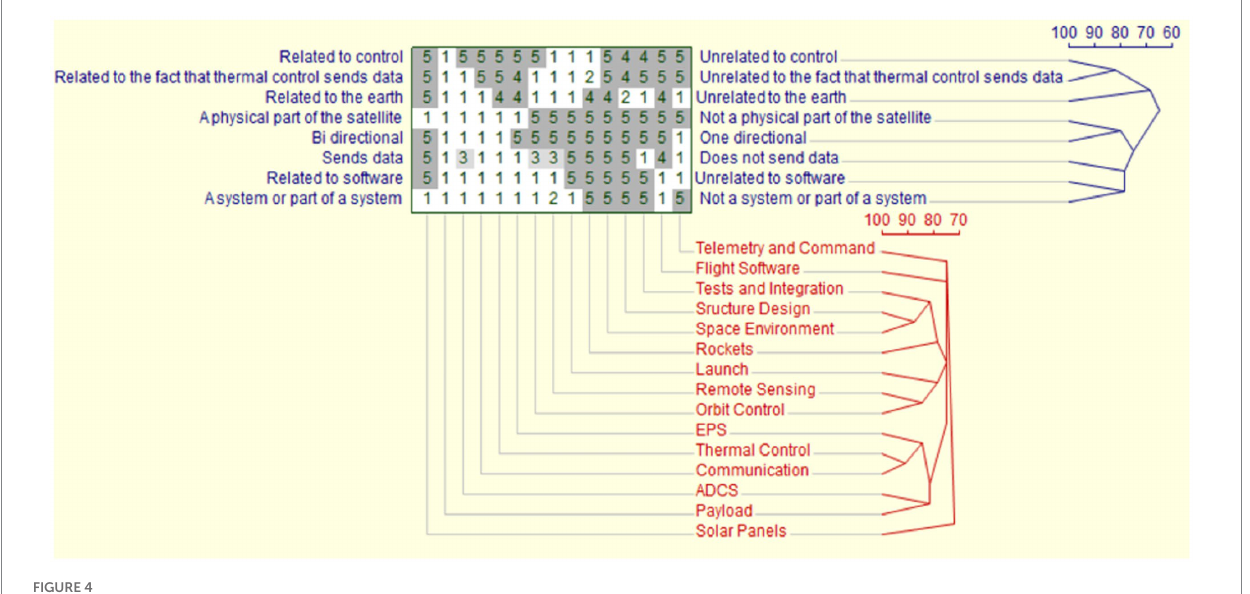
FIGURE 4 John’s first repertory grid.